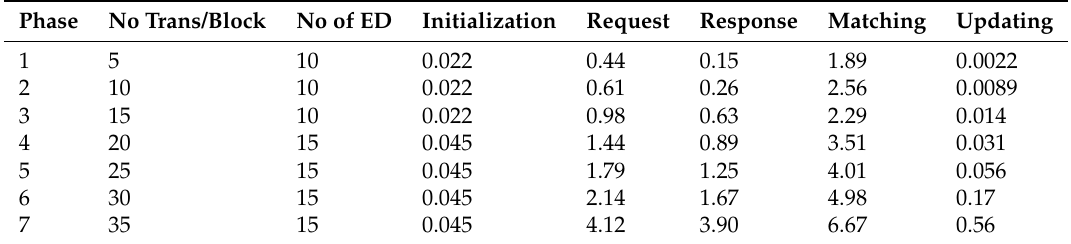
Table 4. Analysis of Edge node made private blockchain